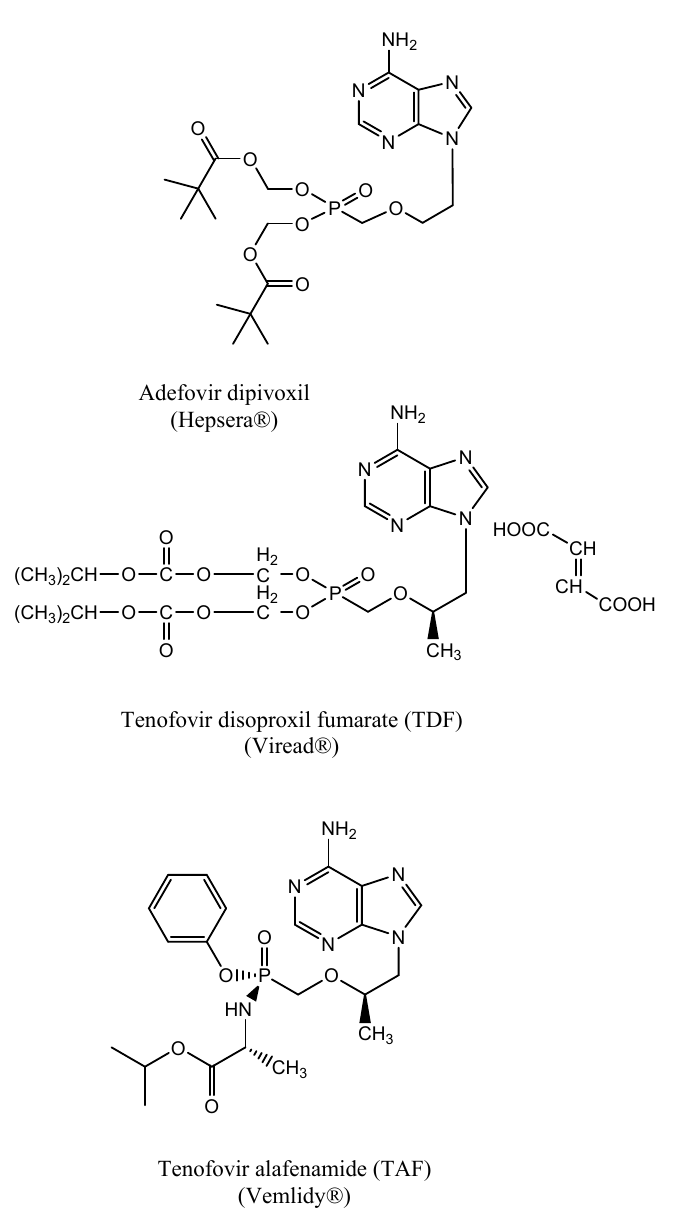
Figure 1. Genealogy of tenofovir.